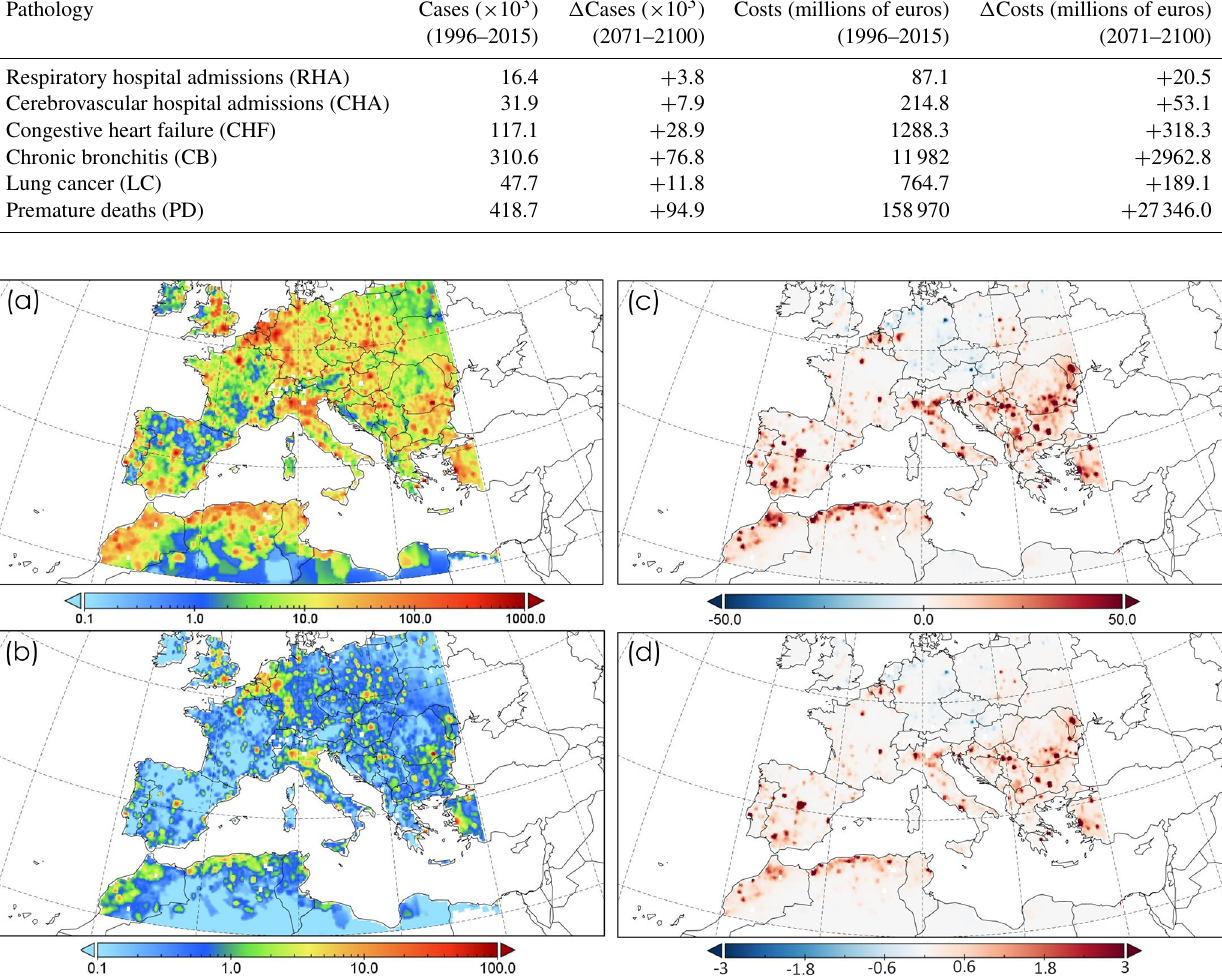
Figure 5. (a) Present cases of chronic bronchitis (CB) and (b) associated costs, in millions of euros. (c) Changes projected in CB cases and (d) changes in costs (millions of euros) under the RCP8.5 scenario